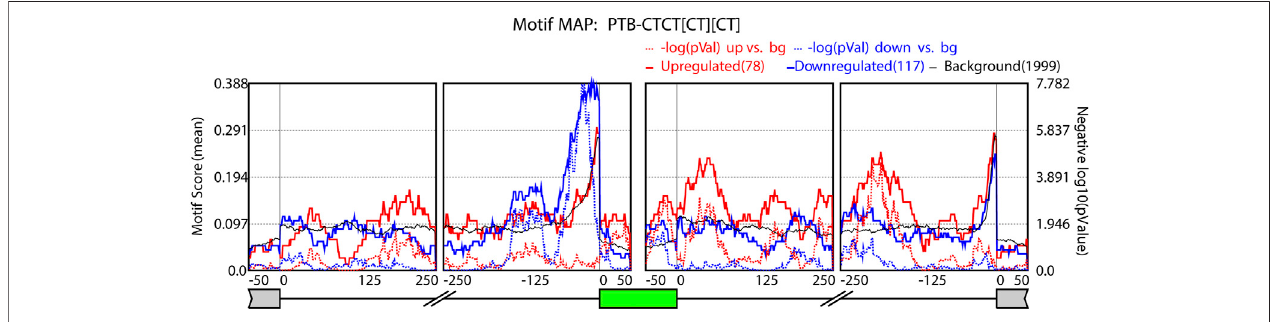
FIGURE5| PTBP1 RNAmap.RNAmapshowingenrichmentofPTBmotifnearalternativelysplicedexons.Thedottedlinesindicatethesigni fi canceofenrichment versus background in − log10( p -value). The number of events in each category (upregulated, downregulated, or background) is indicated in the